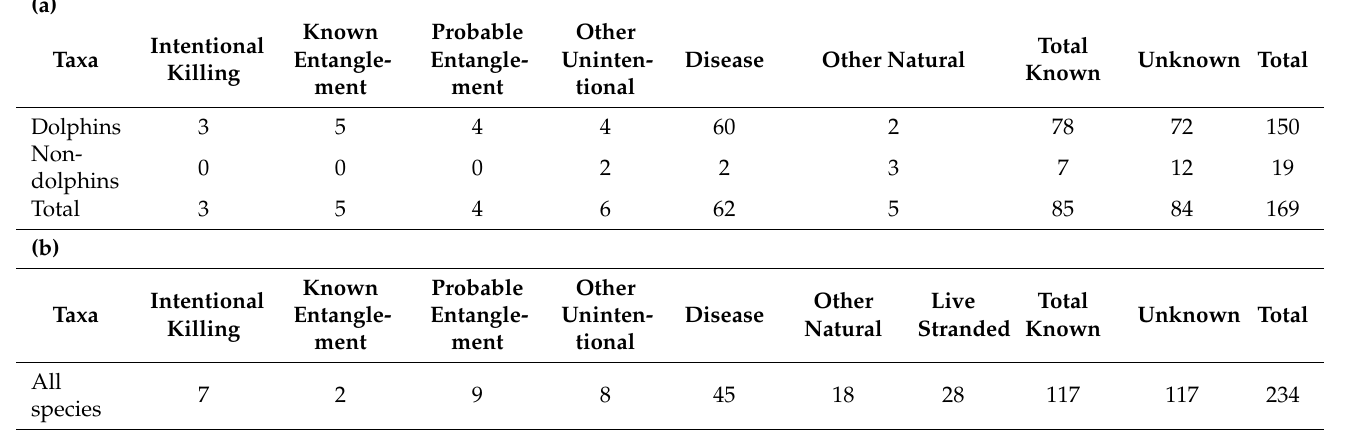
Table A3. Frequencies of the circumstance of death categories for necropsied specimens of all species from the St Vincent Gulf Bioregion collected for the South Australian Museum. (a) 2009–2020. (b) 1990–2008 data (Segawa and Kemper, 2015) were as initially assigned and were not re-evaluated with regards to the categories Other Natural and Live Stranded i.e., cases involving disease remained in this category.